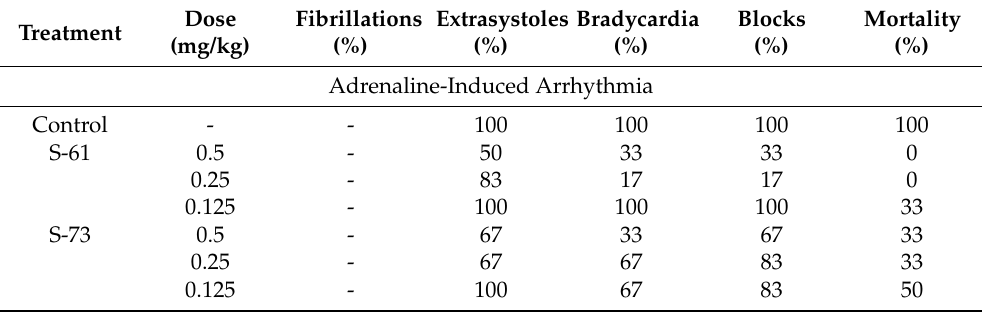
Table 2. The prophylactic antiarrhythmic activity of pyrrolidin-2-one derivatives in adrenaline-, calcium chloride-, and aconitine-induced arrhythmia